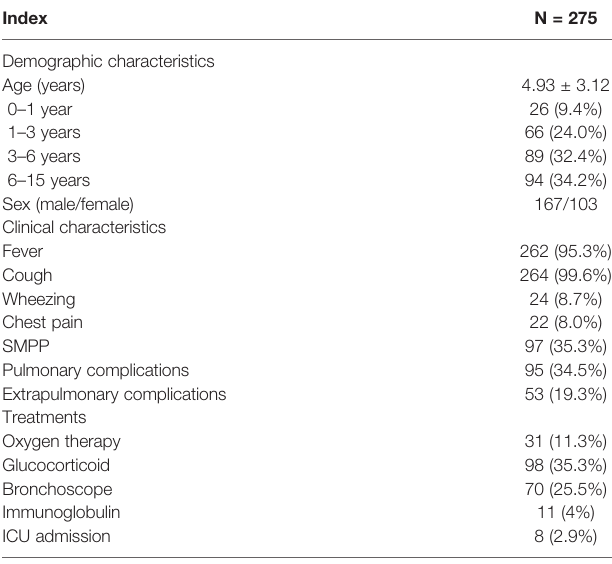
TABLE 1 | Demographic and clinical characteristics of 275 patients with MPP.